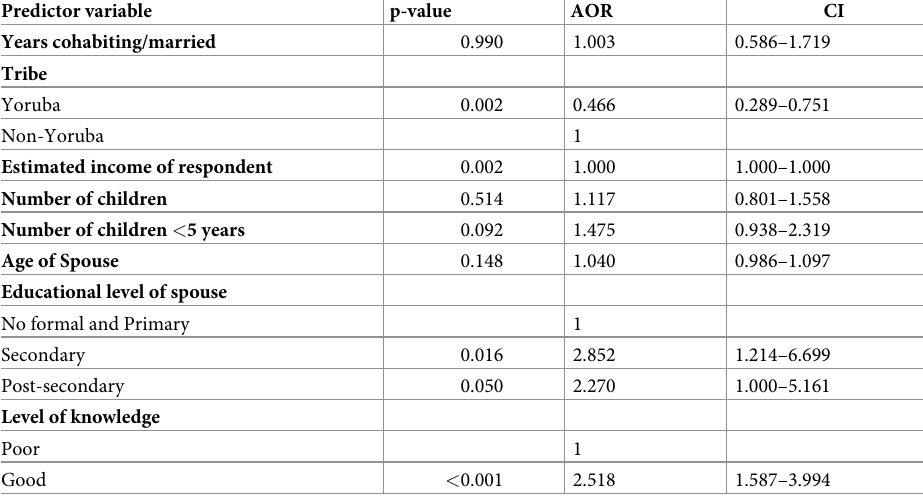
Table 10. Predictors of male involvement of maternal, newborn and child